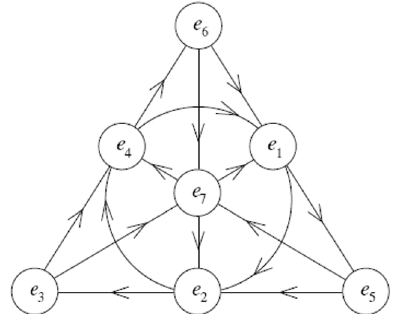
Figure 3 . An oriented Fano plane, figure 1 in [29] for Cartan-Schouten-Coxeter [20, 21] octonion conventions. On each of the 7 lines (including the circle) there are 3 points e.g. 1,2, and 4 on a circle. The octonion multiplication rule (2.2) is represented in the oriented Fano plane with the arrows indicating the positive directions for multiplication. For example, one can see from the oriented circle that e 1 · e 2 = e 4 , which is also shown in the first term in (2.2) as f 124 = +1 .